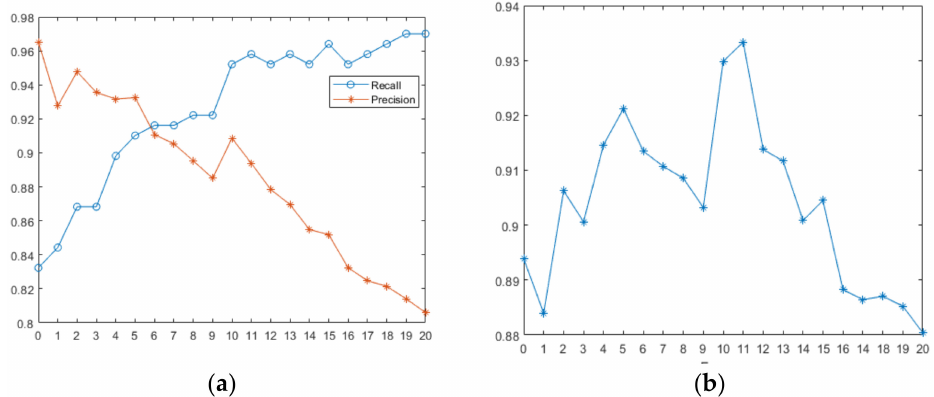
Figure 7. Performance of Recall, Precision, and F-score with different θ d . ( a ) Recall and Precision. ( b ) F-score.